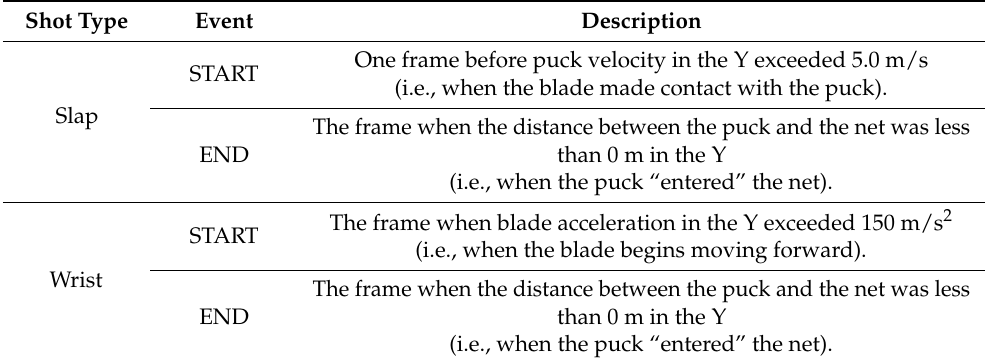
Table 3. Definitions of shot events used to calculate shooting performance metrics with the Vicon